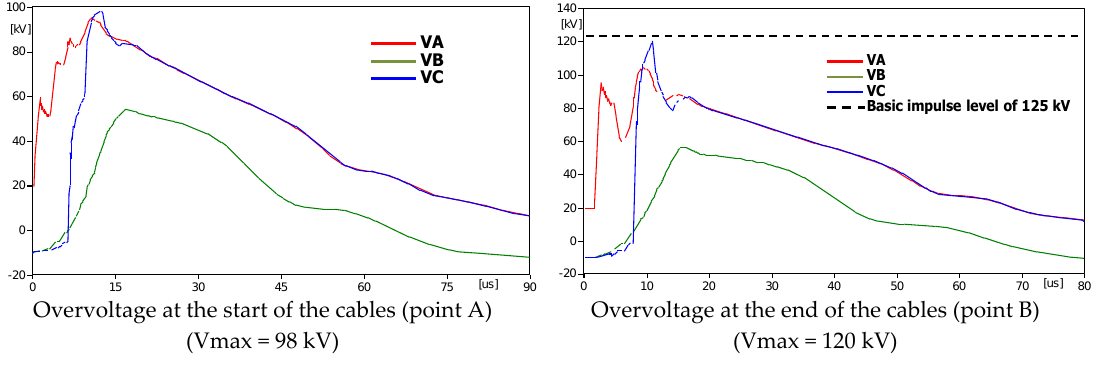
Energies 2019 , 12 , x FOR PEER REVIEW Figure 37. A 3 00 m underground cable. Figure 37. A 300 m underground cable. Figure 37. A 3 00 m underground cable.